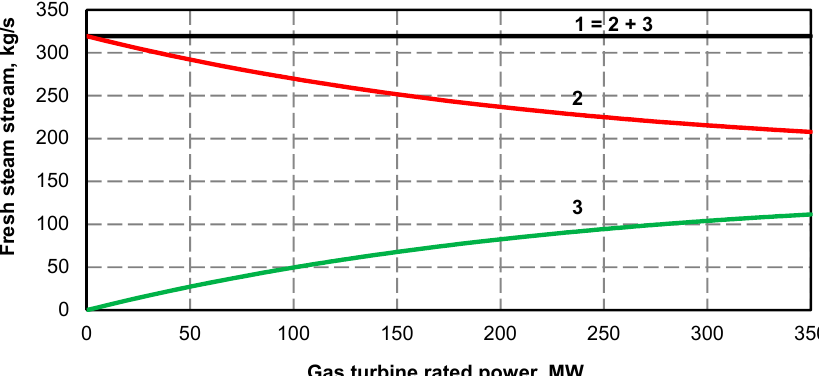
Figure 24. Fresh steam streams as a function of gas turbine rated power: 1—maximum fixed steam stream of 319.4 kg / s fed to the steam turbine 2—steam stream generated in the steam boiler, 3—steam stream generated in the recovery boiler.